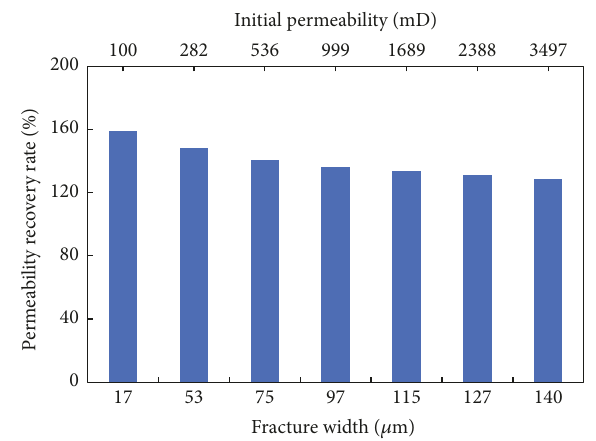
Figure 11: Permeability enhancement after acidizing treatment in drilling-fluid-damaged core samples (core samples